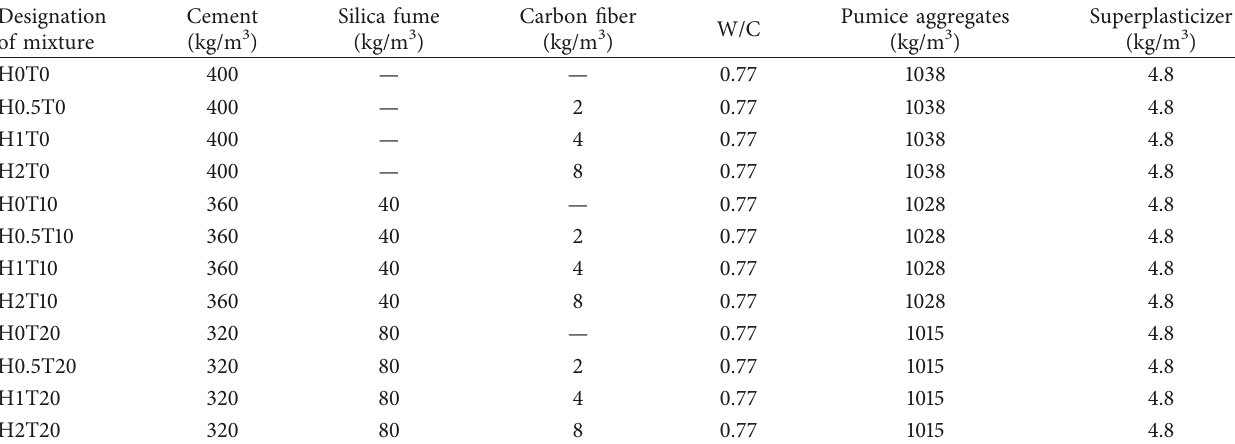
Table 3: Mixture proportion of concretes.